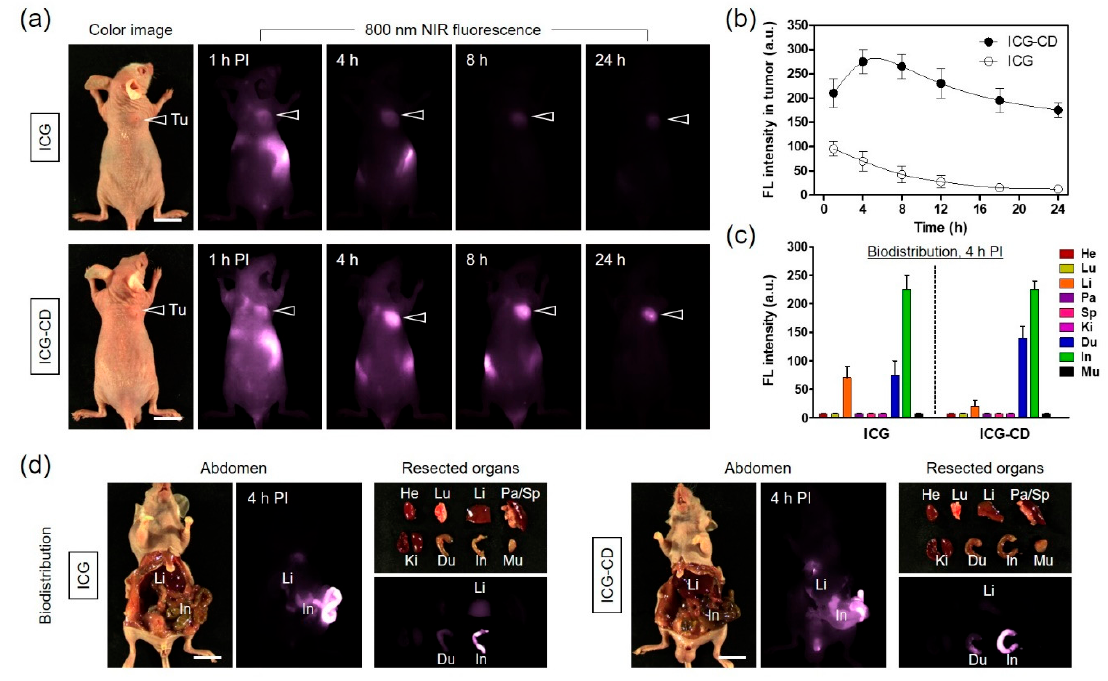
Figure 4. In vivo HT-29 tumor targeting efficiency of free ICG and the ICG-CD complex. ( a ) NIR fluorescence imaging for 24 h post-injection of ICG and the ICG-CD complex. ( b ) Time-dependent fluorescence intensity at tumor sites targeted by ICG and the ICG-CD complex. ( c ) Quantitative fluorescence analysis of intraoperative dissected organs at 4 h post-injection of ICG and the ICG-CD complex. ( d ) Abdominal exploration and resected organs imaged at 4 h post-injection of ICG and the ICG-CD complex. Tumor mice were intravenously injected with 10 nmol of ICG or the ICG-CD complex and imaged for 24 h. The tumor site is indicated by an arrowhead. Abbreviations: Du, duodenum; He, heart; In, intestine; Ki, kidneys; Li, liver; Lu, lungs; Mu, muscle; Pa, pancreas; Sp, spleen; Tu, tumor; and PI, post-injection. Scale bars = 1 cm. Images are representative of three independent experiments. All NIR fluorescence images have identical exposure and normalization. Data are expressed as the mean ± S.D. of the three independent experiments.